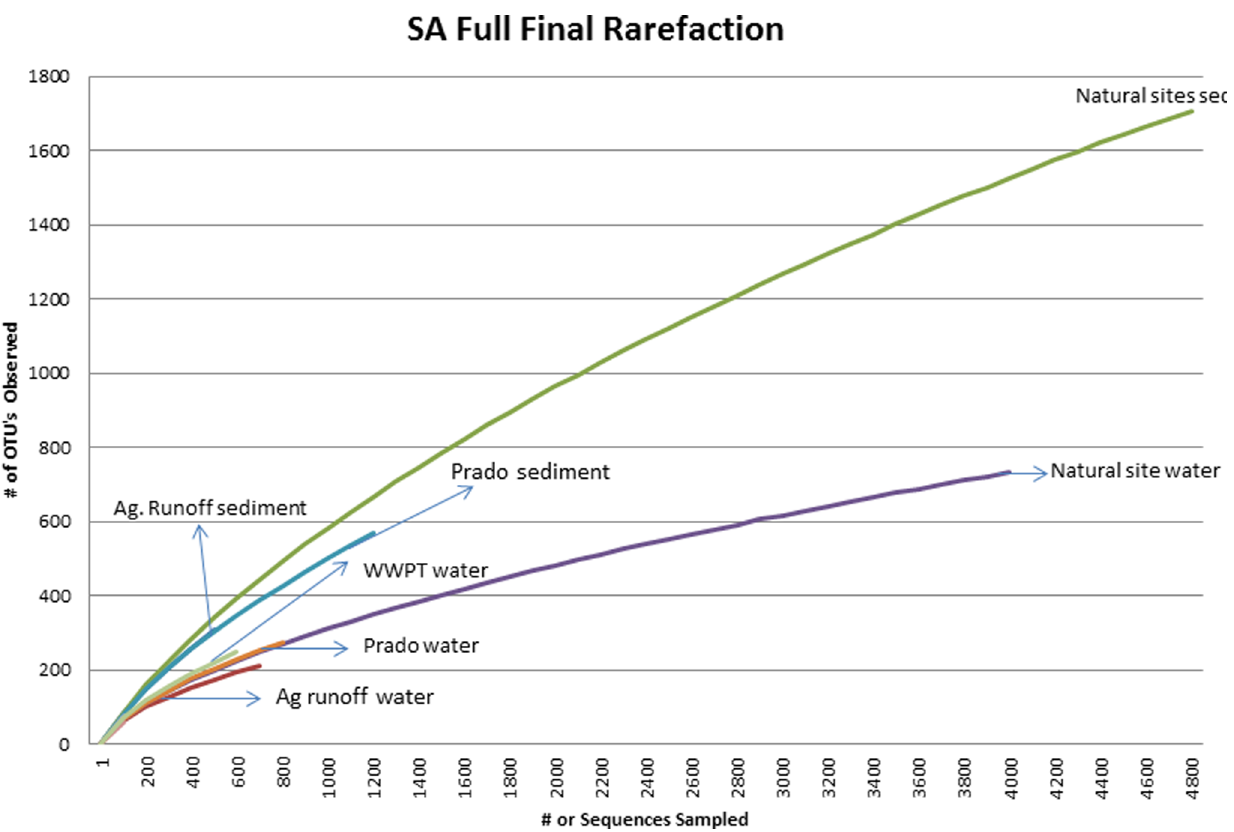
Figure 1. Rarefaction curves of seven sources at cutoff of 3%. Two sources (urban runoff water and sediment) are not included because of low sequence tags obtained.